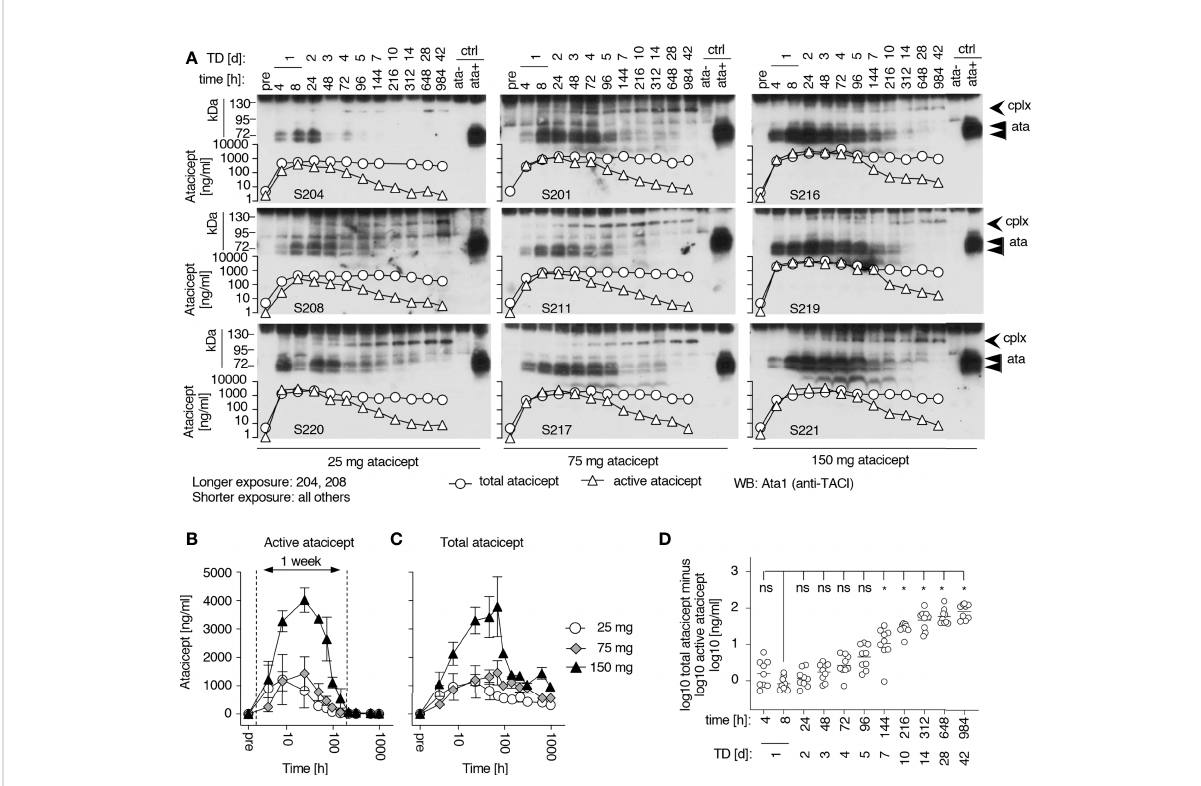
FIGURE 2 Time versus concentration pro fi les for subjects receiving increasing doses of atacicept and corresponding Western blot analyses of serum samples. (A) Active and total atacicept levels were measured in serum samples of healthy subjects who received a single dose of atacicept (25, 75 or 150 mg). 0.5 µl of serum samples at different time points were also analyzed by denaturing (SDS) but non-reducing Western blot with an anti-TACI (Ata1) antibody. Superimposed graphs show concentrations of active (triangles) or total (circles) atacicept measured in the same samples. cplx: atacicept- containing complex. ata, atacicept. TD, treatment day. (B) Active atacicept as a function of time in sera of subjects receiving a single dose of 25 (opened circles), 75 (grey diamonds) or 150 mg (black triangles) atacicept (n=3 per dose. Mean ± SEM). The time interval corresponding to the fi